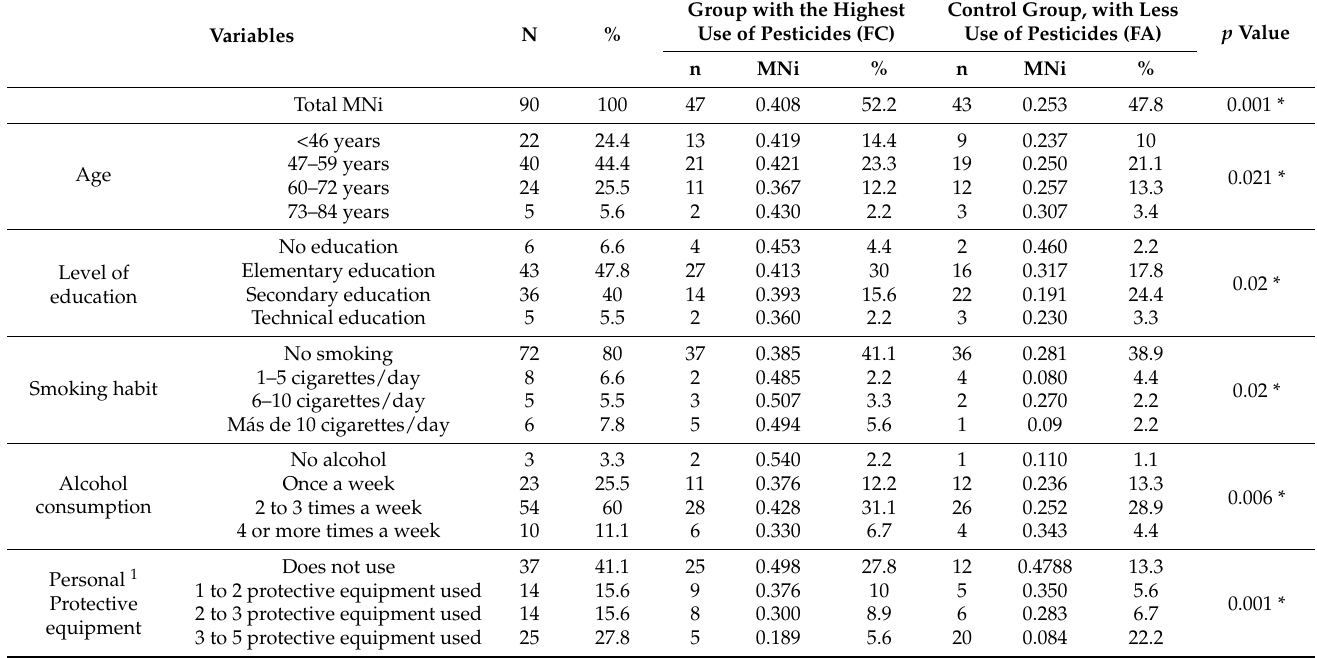
Table 3. Total micronuclei (MNi) evaluated in peasant corn producers according to the sociodemo- graphic characteristics of the locality of Vicente Guerrero in the municipality of Españita, Tlaxcala,